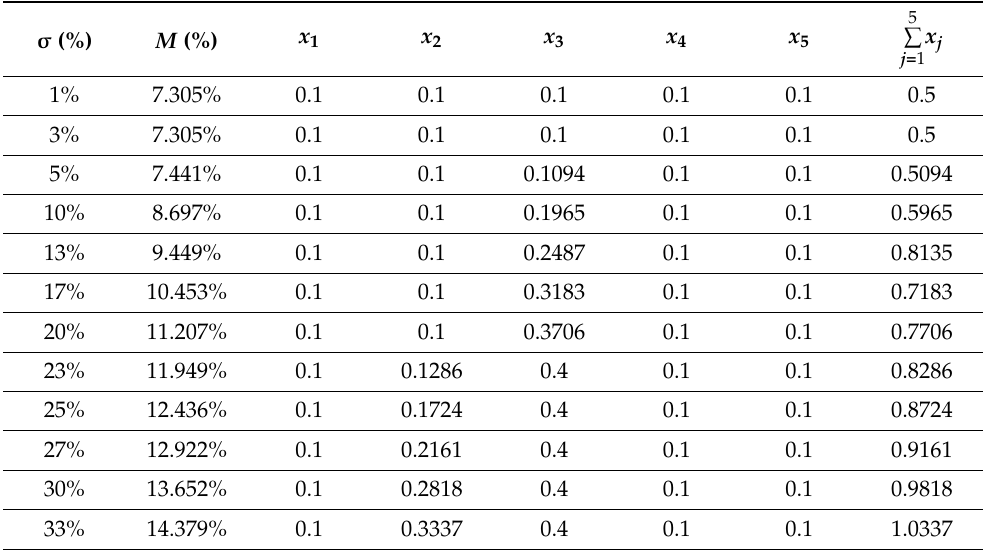
Table 2. The possibilistic efficient portfolios with recession stage by the proposed